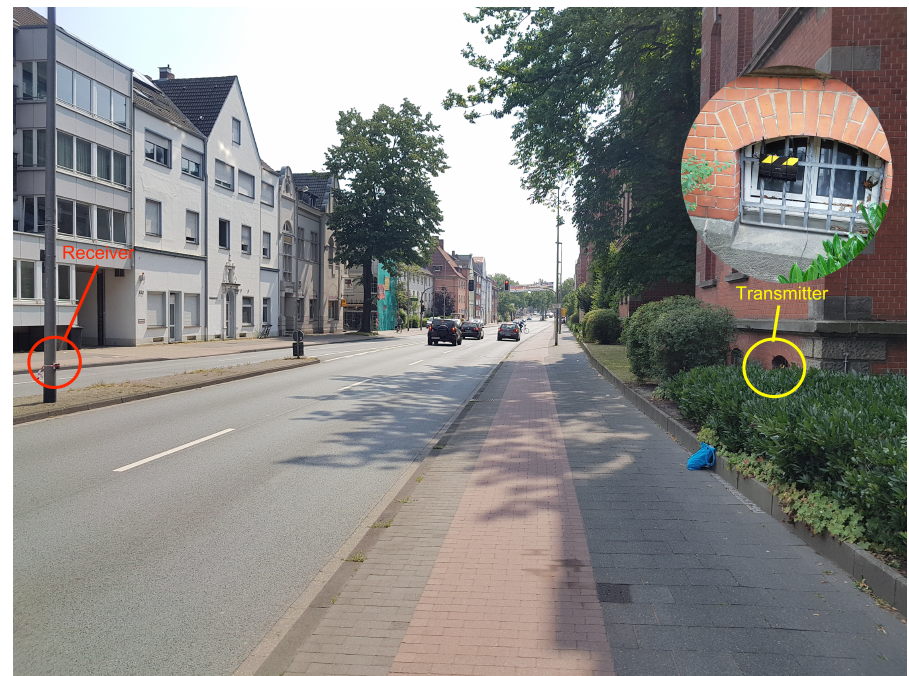
Figure 3. Experimental setup: Scenario 2 (Heavy traffic road: Steinfurter